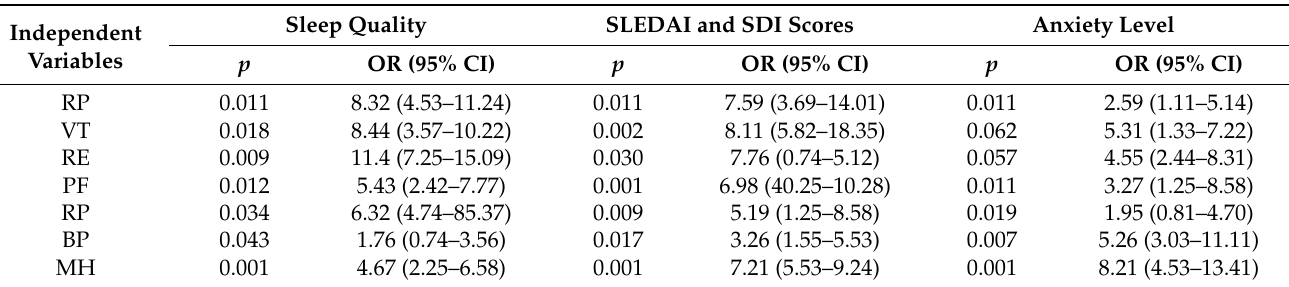
Table 2. Logistic regression of contents of SF-36 on sleep quality, SLEDAI and SDI scores, and anxiety levels of SLE